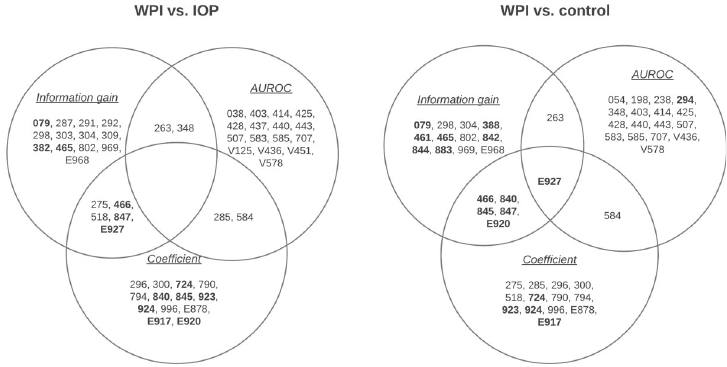
Fig 2. Venn diagram showing the top-ranked (by AUROC, information gain and odds ratio) ICD-9 codes (i.e. clinical diagnoses) found comparing the WPI vs. IOP group and the WPI vs. random controls. Variables in boldface represent higher frequency in the WPI group.